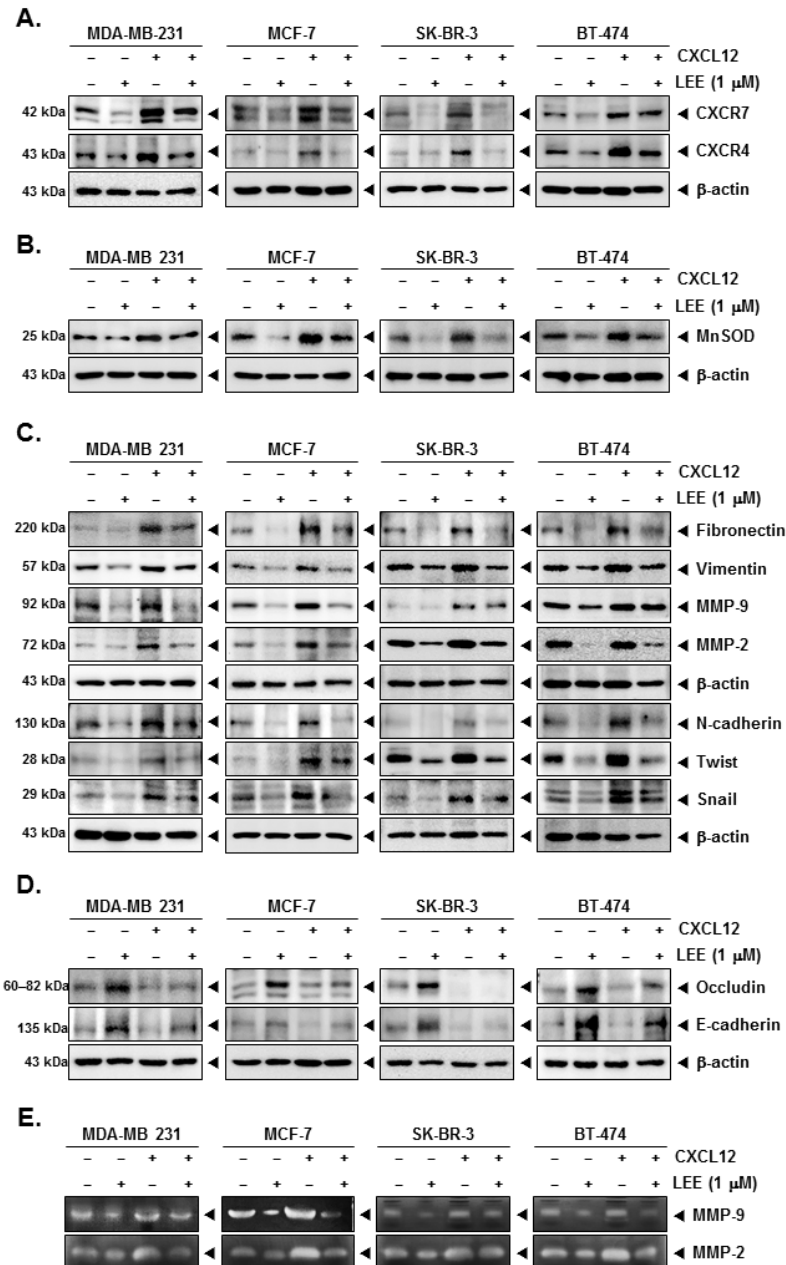
Figure 4. Effects of LEE on CXCR7/4 and several EMT markers in presence of CXCL12 stimulation. The cells were stimulated with CXCL12 (10 ng/mL) and treated with LEE (1 µ M) for 24 h. Whole cell lysates were analyzed by Western blot analysis. The protein expression level of ( A ) CXCR7/4, ( B ) MnSOD, and ( C , D ) several EMT markers (fibronectin, vimentin, MMP-2/9, N-cadherin, twist, snail, occludin, E-cadherin) were probed using specific antibodies. ( E ) The supernatants were obtained and concentrated, and then activity of MMP-9/2 was evaluated by zymography. All the experiments were individually repeated at least thrice.